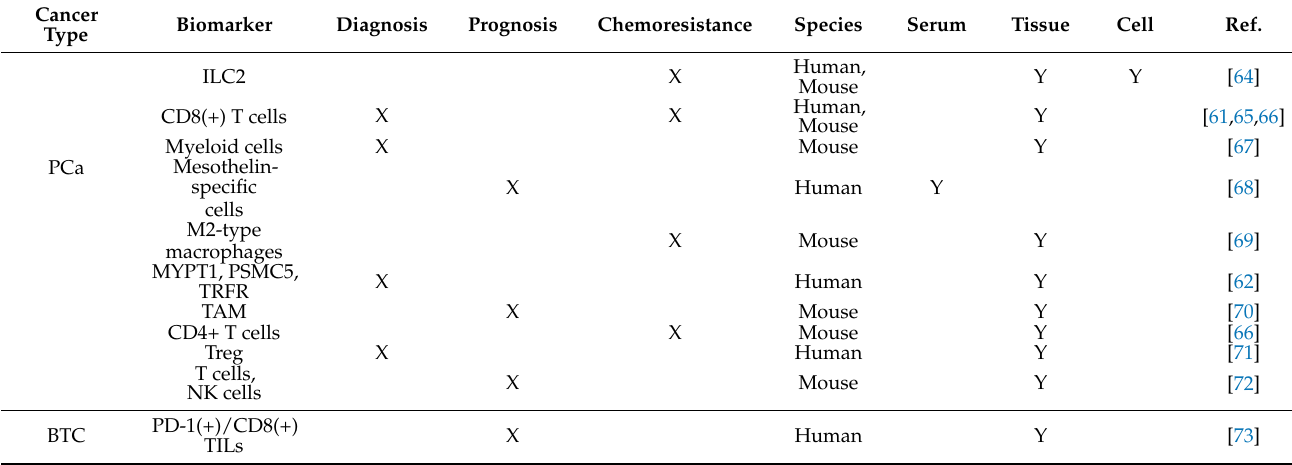
Table 3. Biomarker candidates for immune cells identified in the present systematic